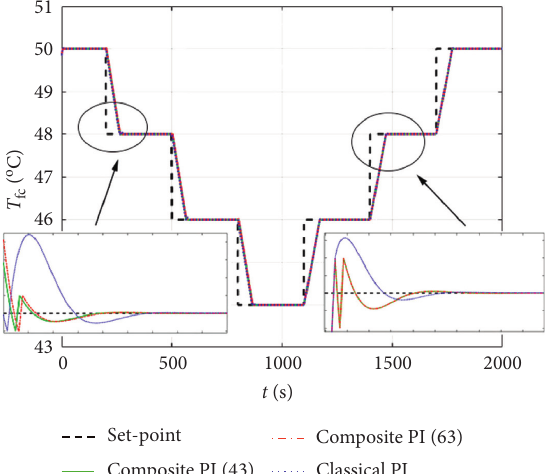
Figure 5: The temperature profiles regulated by the proposed composite PI controller ((37) and (57)) and the classical PI.